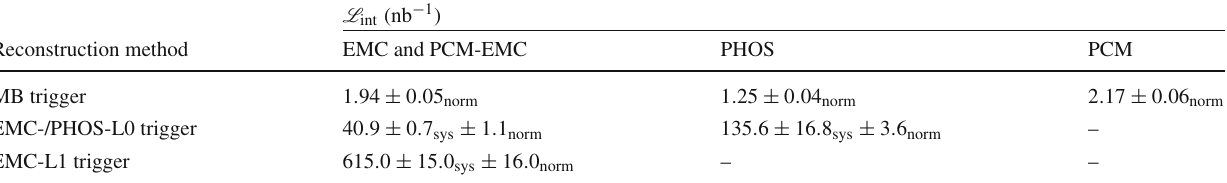
Table 1 The analyzed luminosities considering the individual statis- tics for the different reconstruction methods and triggers. The EMCal related measurements use the same list of good runs as indicated by the combined column. The uncertainties denoted with “sys” reflect the sys-